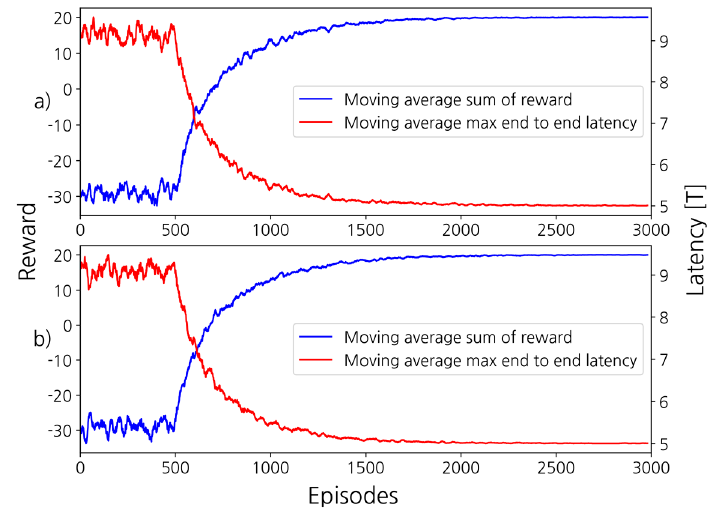
Figure 9. Training result of RL model in topology 1. ( a ): SARL, ( b ): MARL. Table 7. Packet generation scenario in topology 2.